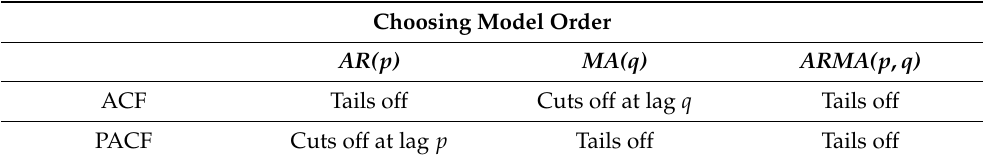
Table 4. Guidelines for how to choose the MA ( q ) , AR ( p ) , and ARMA ( p , q ) models and their associated parameters based on the ACF and PACF.